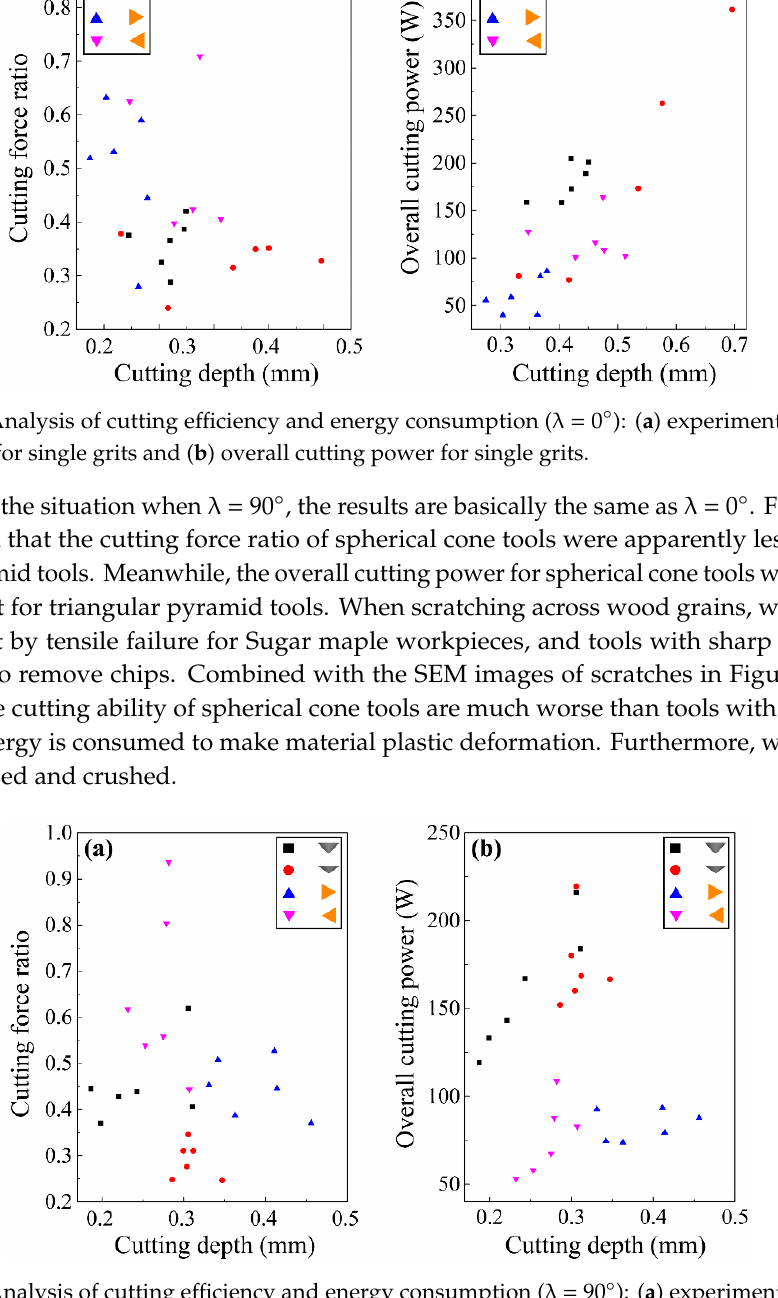
Figure 15. Analysis of cutting efficiency and energy consumption ( λ = 90 ° ): ( a ) experimental cutting force ratios for single grits, and ( b ) overall cutting power for single grits.